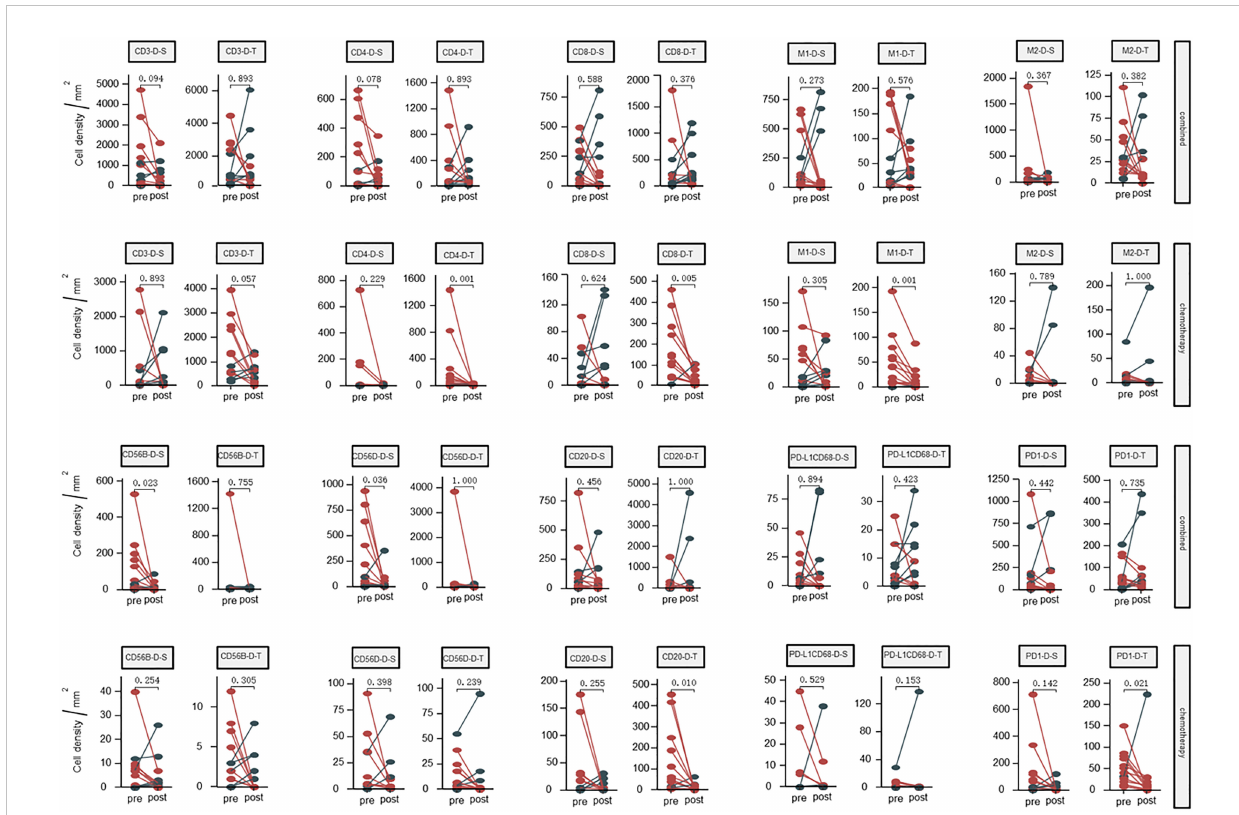
FIGURE 1 Dynamic changes of densities in the tumor microenvironment (tumor and stromal regions) before and after neoadjuvant therapy; Combined, immunochemotherapy; Pre, pre- neoadjuvanttherapy; Post, post- neoadjuvanttherapy; D, density; S, stroma region; T, tumor region; M1, CD68 + CD163 - macrophage; M2, CD68 + CD163 + macrophage; CD56B, CD56 bright NK cell; CD56D, CD56 dim NK cell; P < 0.05, Signi fi cant difference.